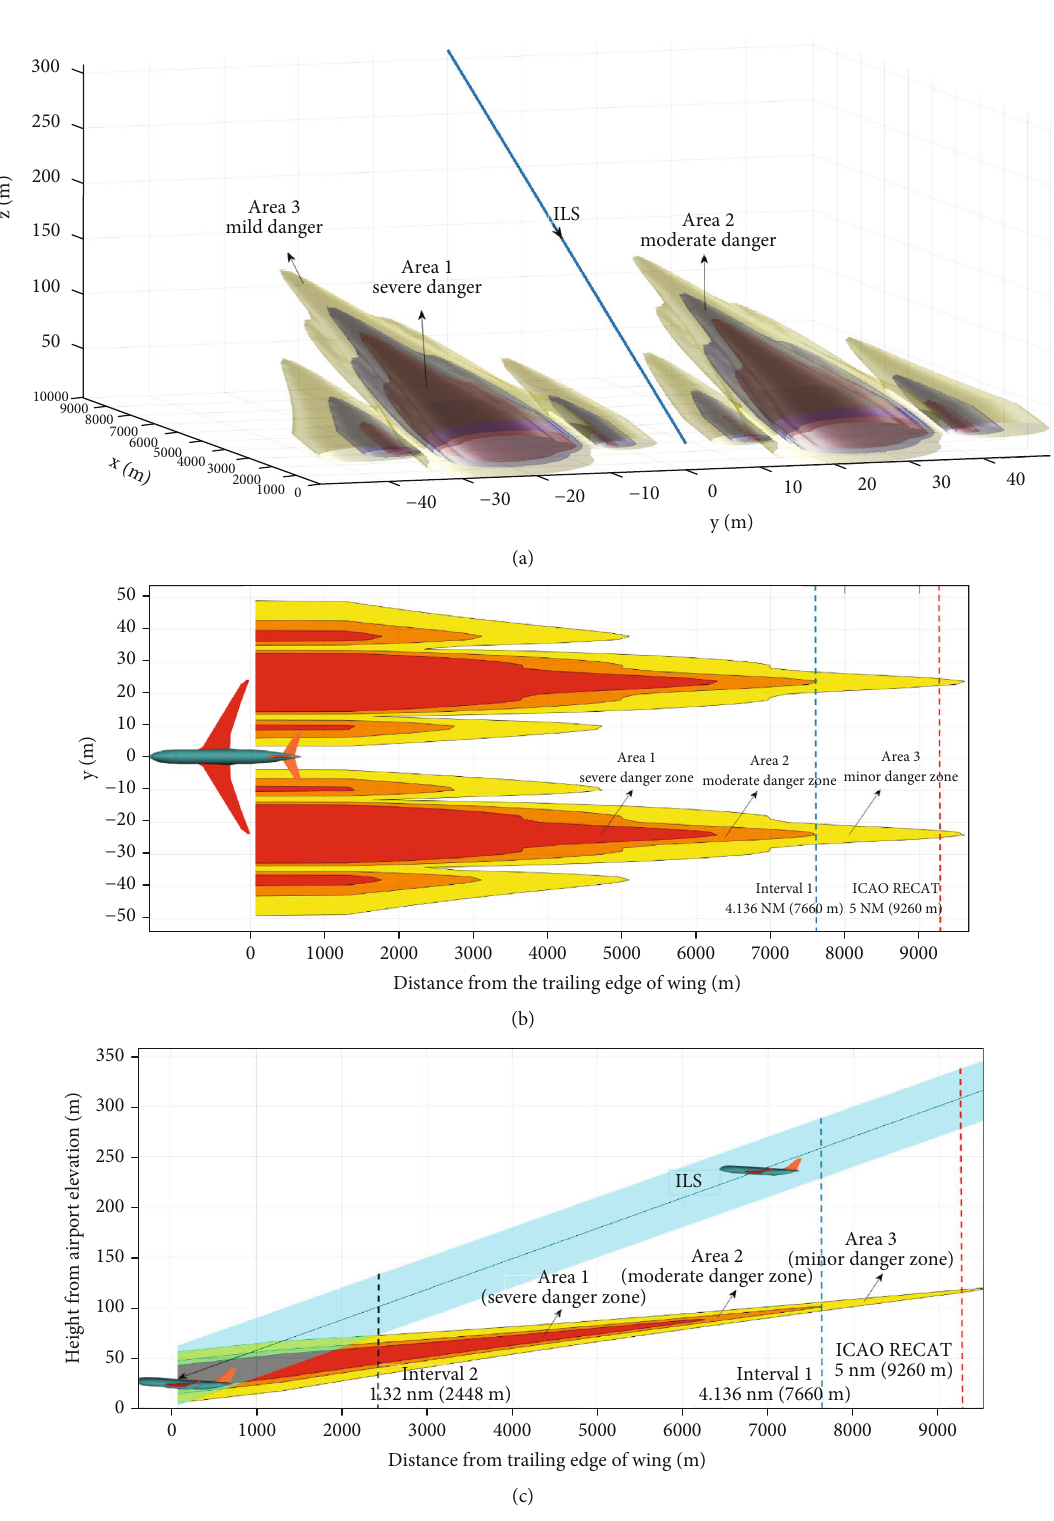
Figure 17: Rollover hazard area. (a) Hazardous area isosurface; (b) the top view of the hazard zone; and (c) the side view of the hazard